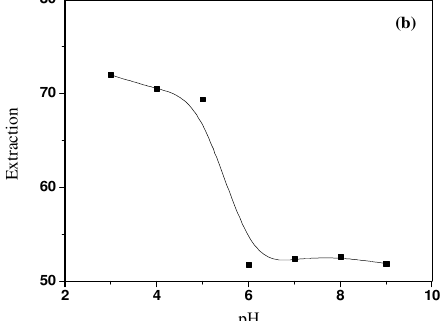
Figure 2 . Effect of pH on the sorption profile of cadmium(II) from aqueous KI media (1% m/v) onto compound II treated PUFs after 1 h shaking time at room